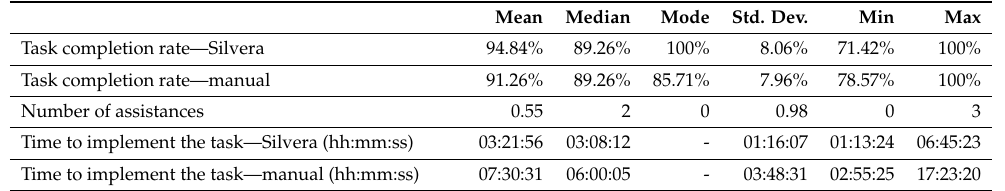
Table 15. Performance results (effectiveness and efficiency).